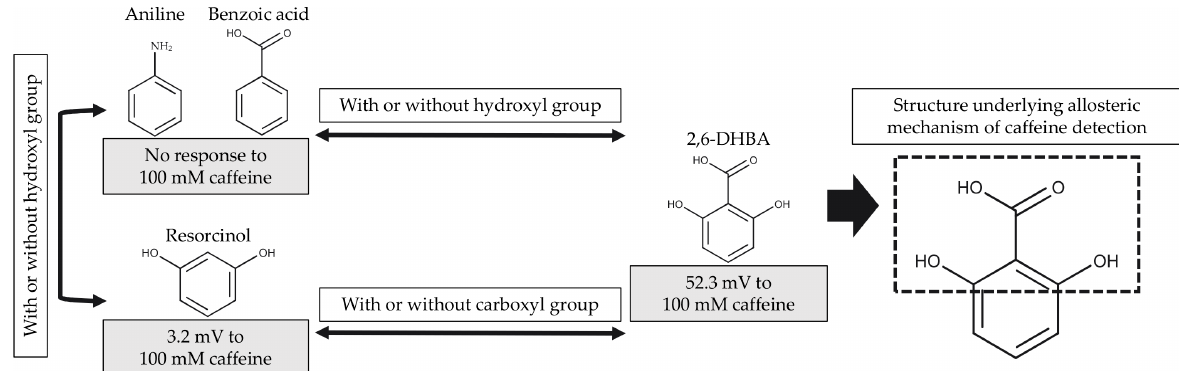
Figure 5. Flow diagram for the derivation of the allosteric mechanism of detecting caffeine. The grey box expresses the maximum response to 100 mM caffeine for the taste sensor modified with each modifier. The black dashed-line box expresses the structure of the allosteric molecule capable of detecting caffeine for taste sensors. Table 3. Elements of the allosteric mechanism and caffeine detection.